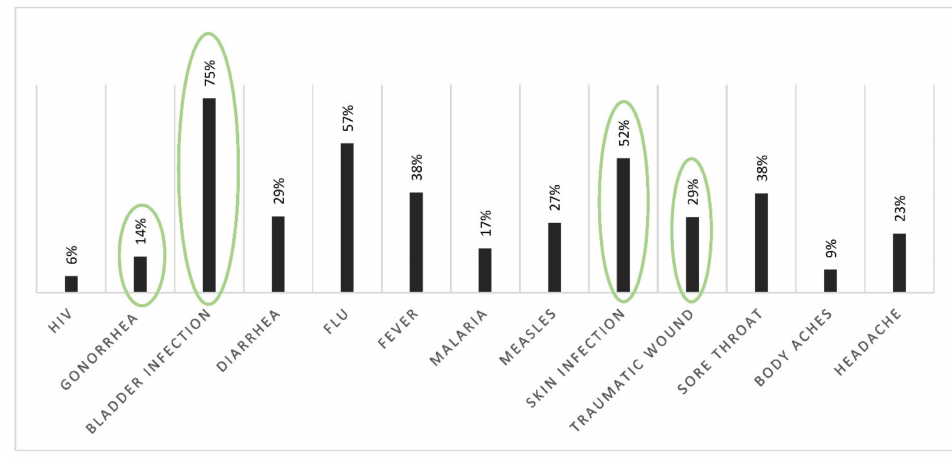
Figure 2. Percentage of responses to question #7: “Which of the following diseases/disorders do you think can be treated with antibiotics?”. Treatable with antibiotics when circled in